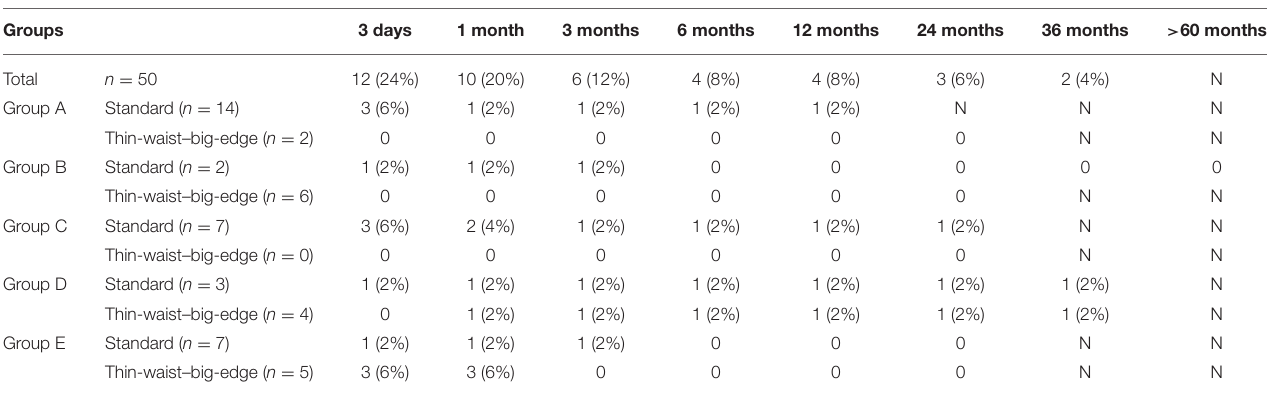
TABLE 2 | Residual shunt after transcatheter